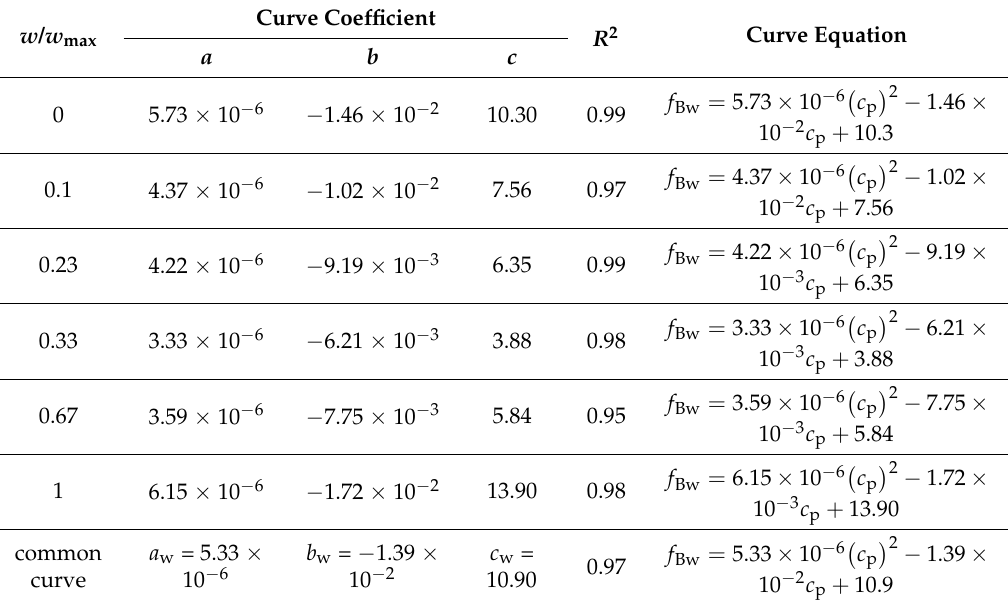
Table 7. Comparison of coefficients and equations of empirical